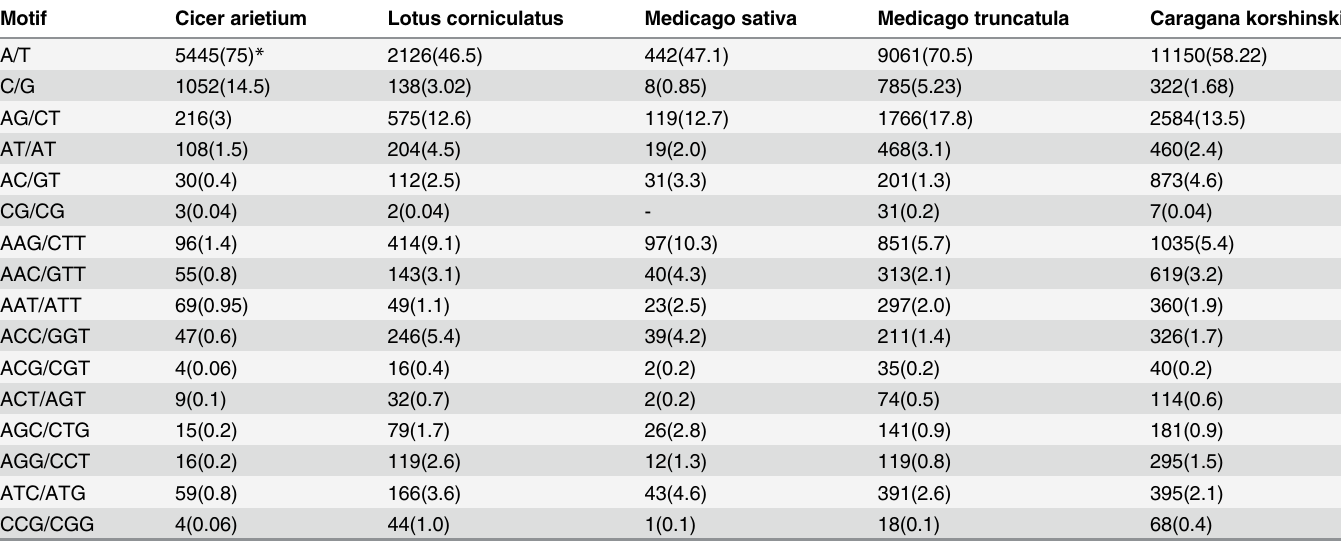
Table 4. Comparasion of three types of motifs for EST-SSR in all the fi ve